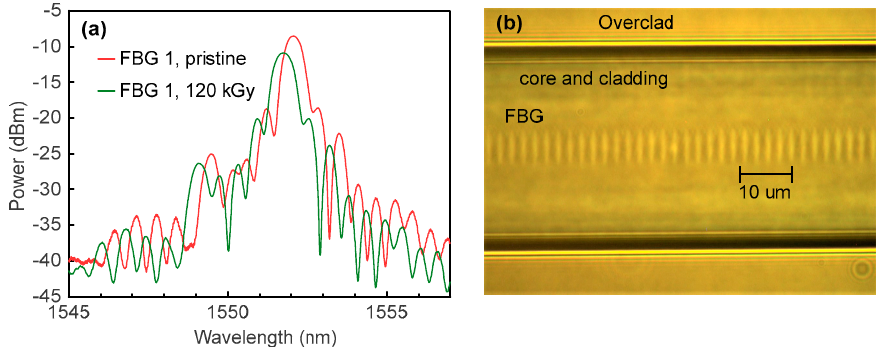
Figure 2. ( a ) Reflection spectrum of the FBG 1 before irradiation and after the second irradiation (120 kGy total dose); ( b ) transmission microscope image of a typical (120 kGy total dose); ( b ) transmission microscope image of a typical FBG.